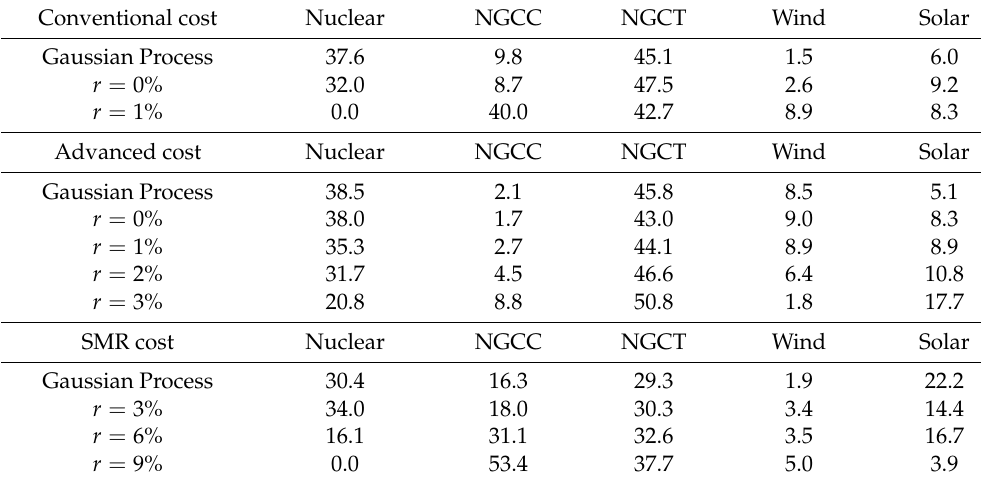
Table 5. Portfolio